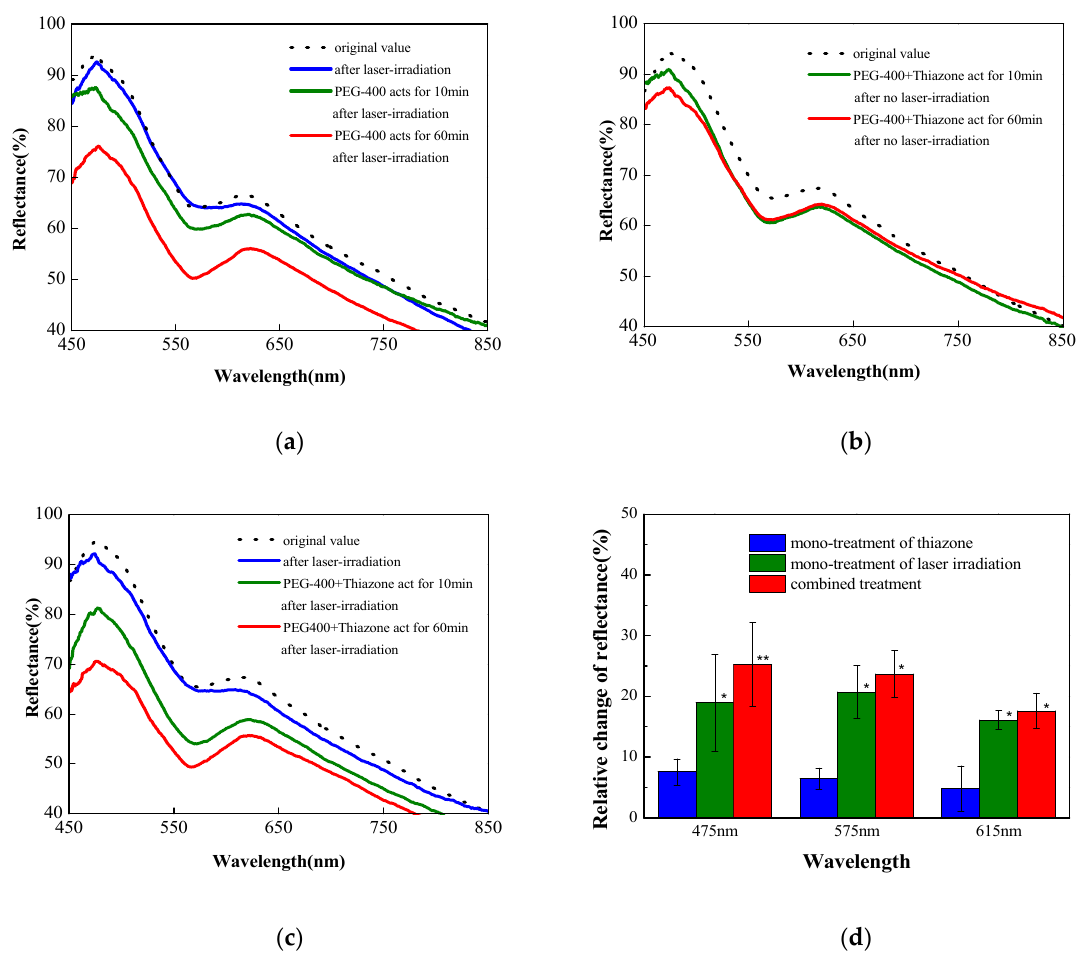
Figure 2. Reflectance spectra of in vivo rat skin with ( a ) mono-treatment of thiazone without laser irradiation, ( b ) mono-treatment of laser irradiation at 0.5 J/cm 2 without thiazone, ( c ) combined treatment at 0.5 J/cm 2 . ( d ) The relative change of the reflectance in 60 min at 0.5 J/cm 2 with different treatment, * p < 0.05; ** p < 0.01.